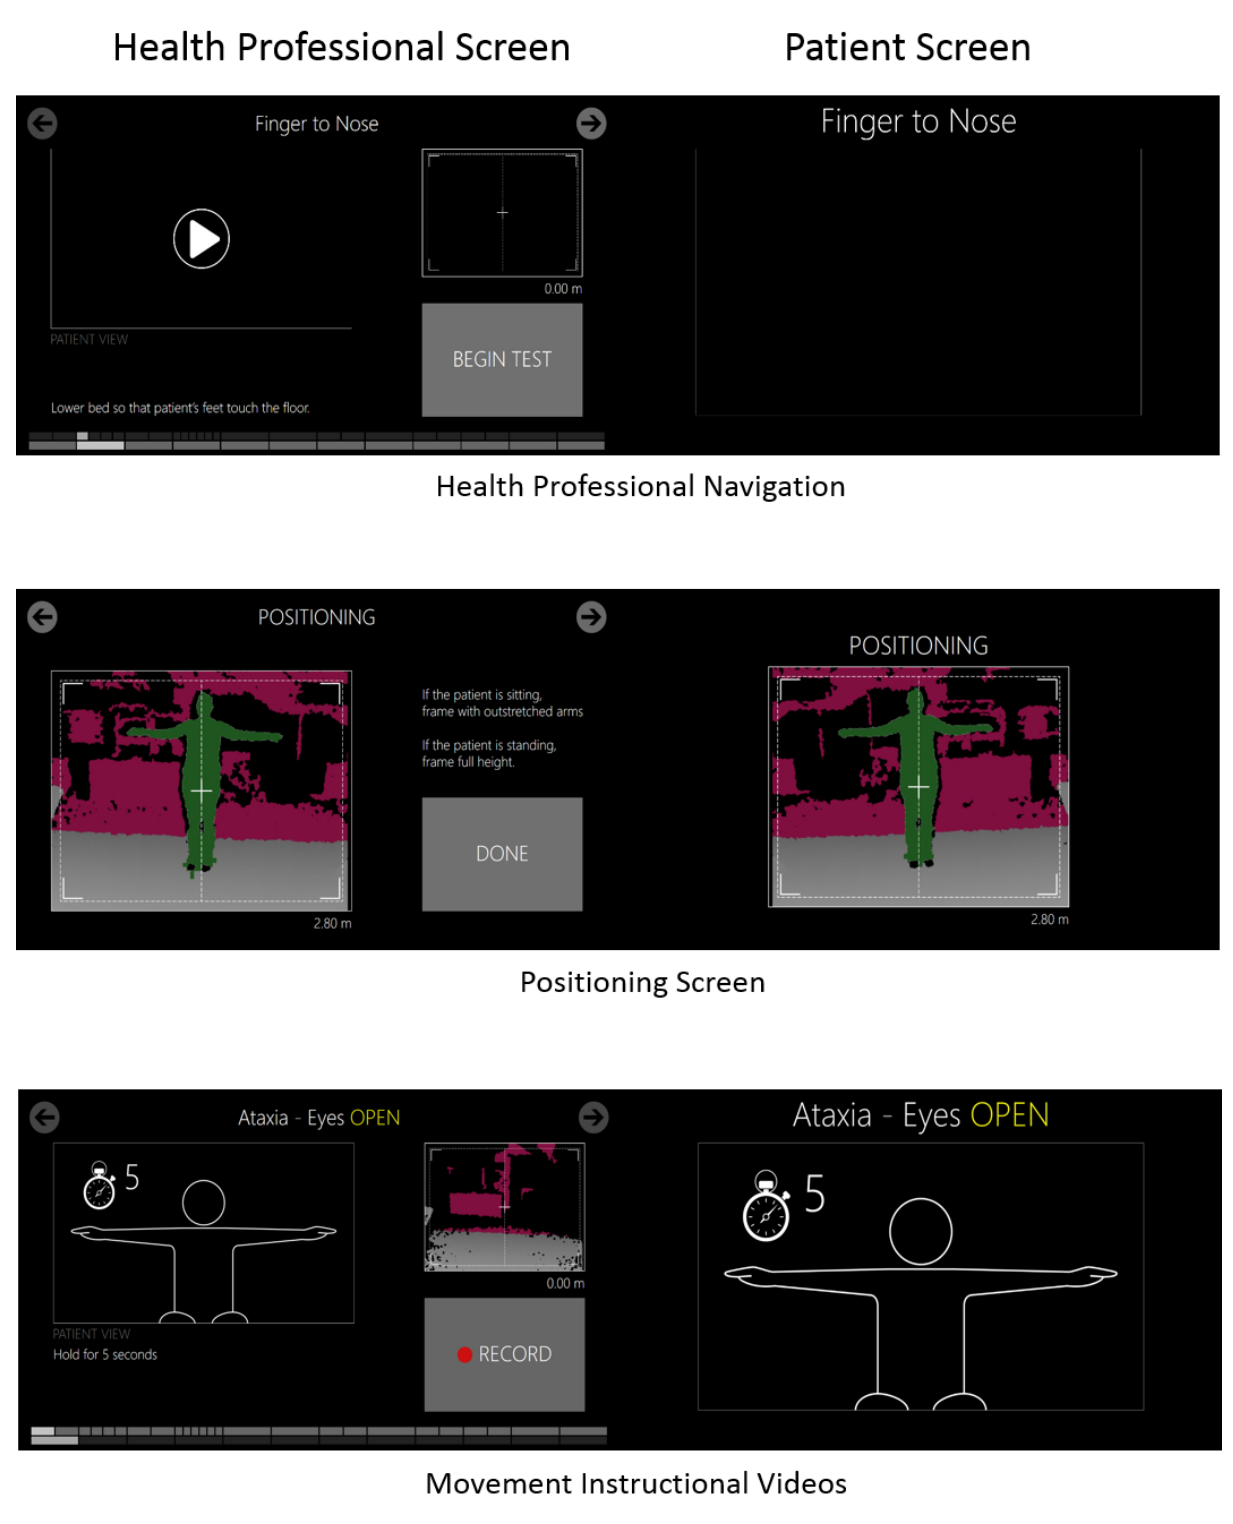
Figure 3. Screenshots of interface: health professional screen on the left and patient screen on the right. Top, navigational elements; middle, positioning feature; bottom, movement instructional videos.